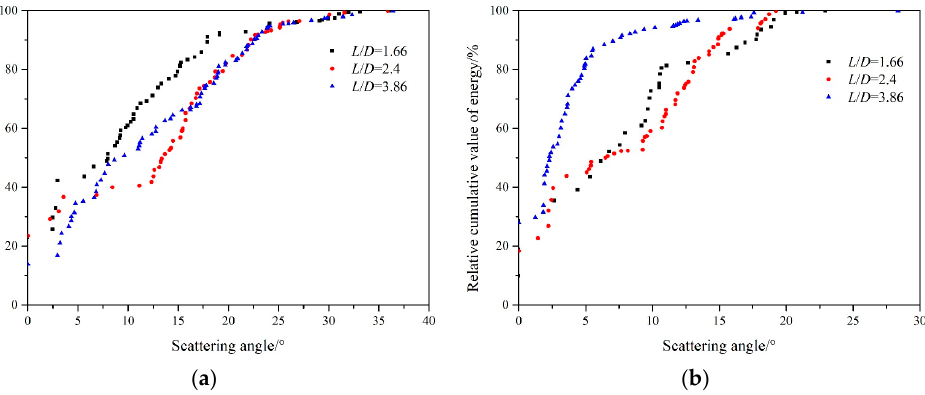
Figure 16. Relative cumulative energy distribution of EFP and target fragments. ( a ) Target fragment; ( b ) EFP fragment.